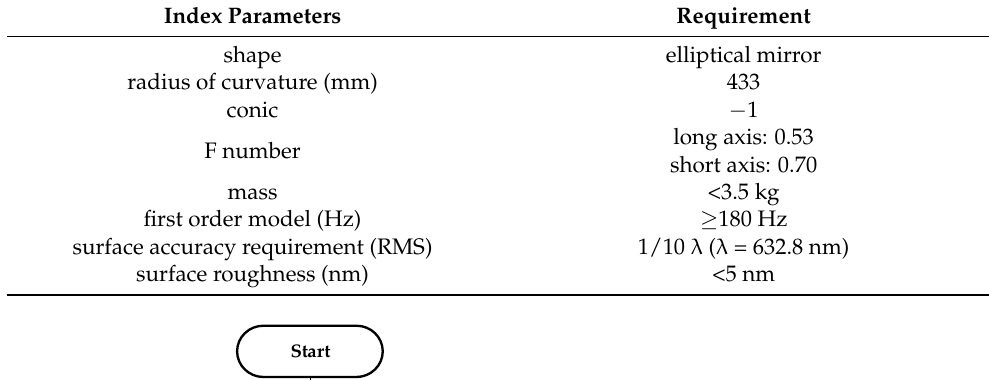
Table 1. Requirement of main mirror index.